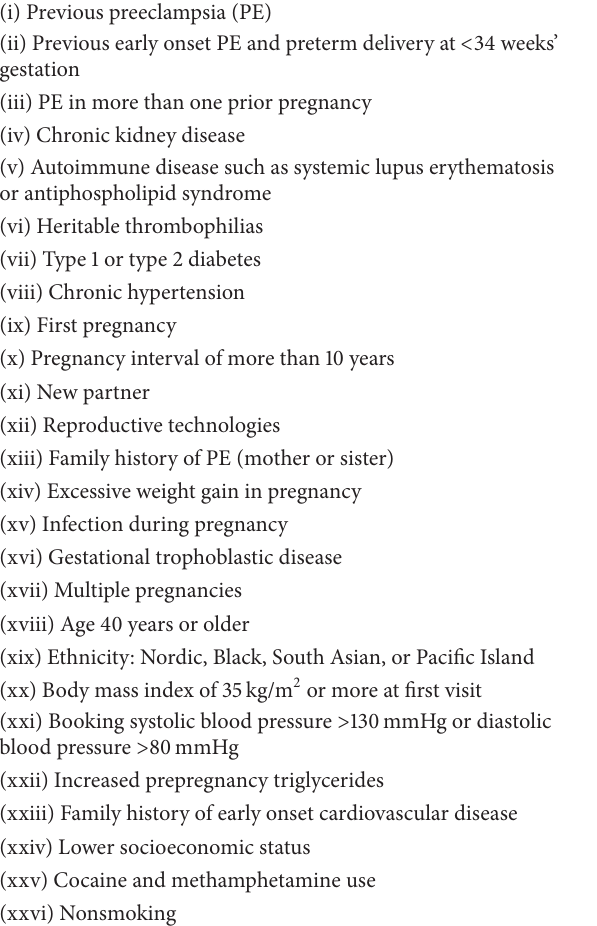
Table 2: Recognized maternal risk factors for preeclampsia